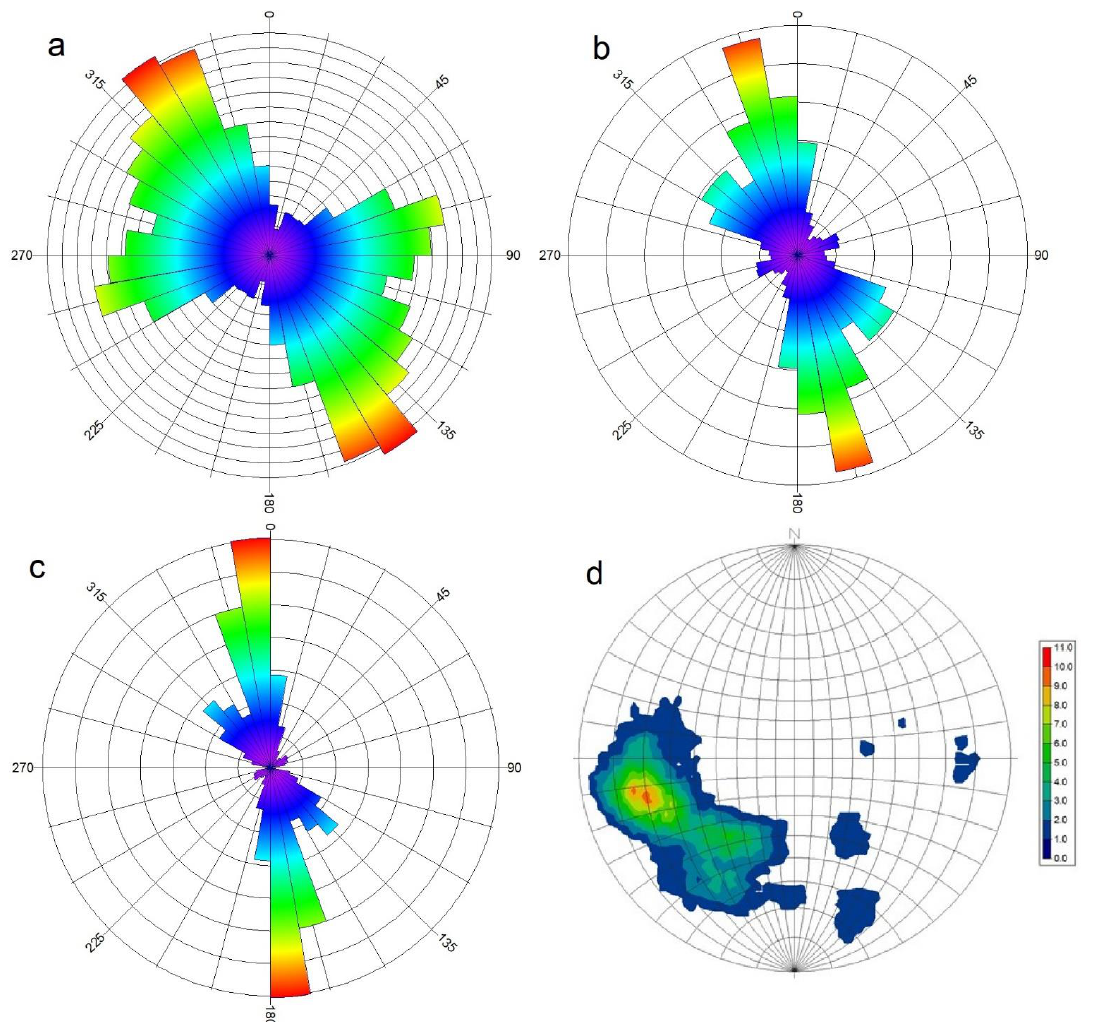
Figure 8. ( a ) Orientation of faults at Shadan on a rose diagram; ( b ) orientation of quartz veins and vein sets at the Shadan deposits on a rose diagram; ( c ) width-azimuth rose diagram plot of all quartz illustrating a strong preferred orientation. This plot is constructed in order to reduce the data scatter caused by the thin networked veins; ( d ) orientation data extrapolated from vein sets measured are plotted on a stereonet. Note the presence of a general northwest vein trend as shown on the equal area stereographic projection of contoured poles to quartz veins. This plot shows that the majority of veins are near vertical.